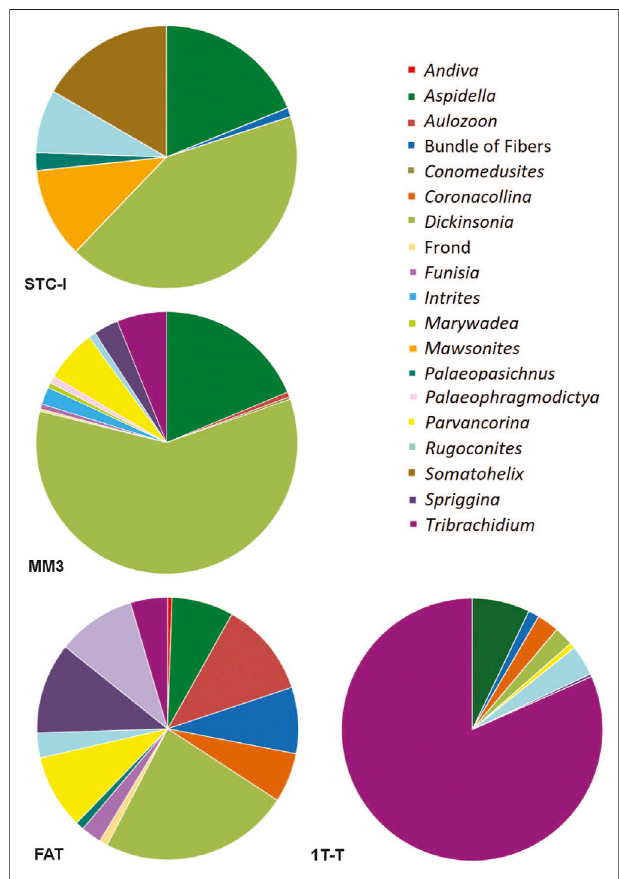
FIGURE 8 | Pie charts illustrating the community composition and relative abundance of bedding planes STC-I, TC-MM3, 1T-F, and 1T-T, all from the ORS